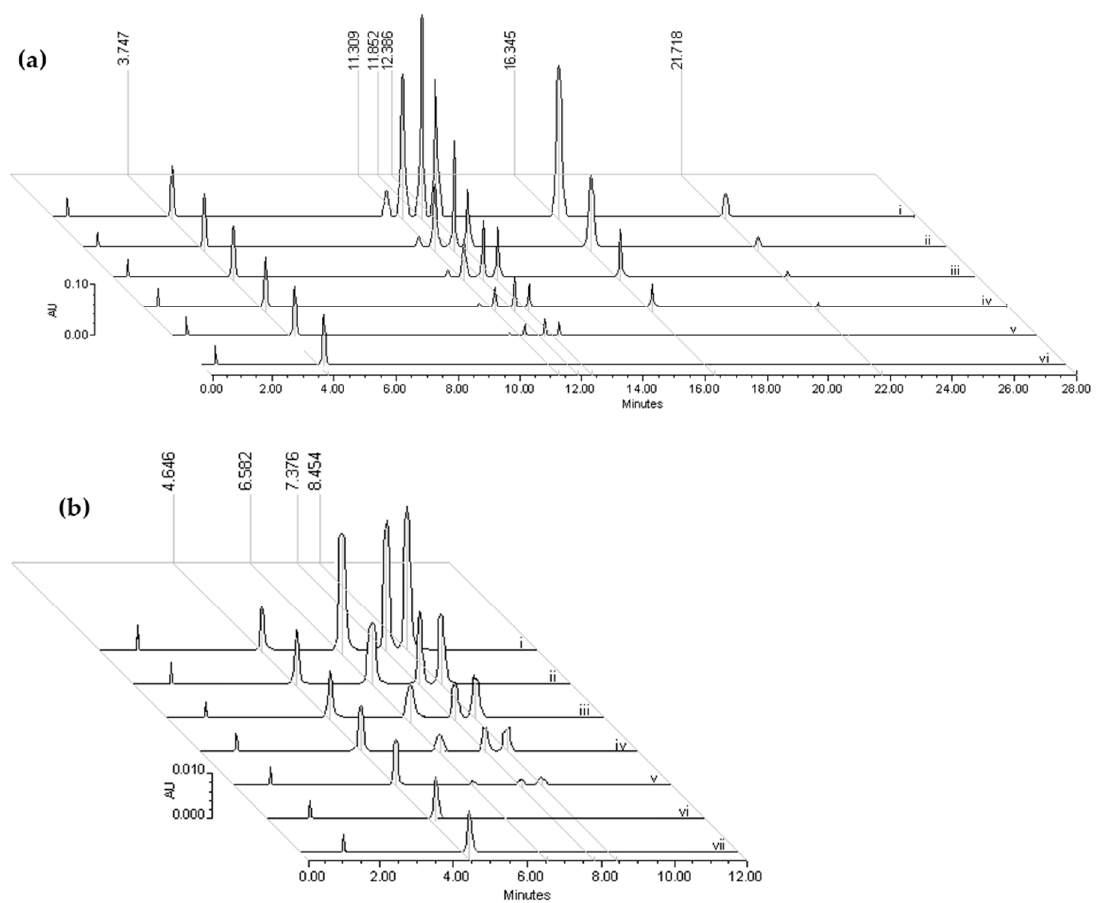
Figure 2. ( a ) Chromatographic profile of the concentration curves of the flavonoids (standards) present in the anxiolytic fraction of T. Americana ; and ( b ) the concentration curves of standards of m -HPAA, p -HPAA and DOPAC.